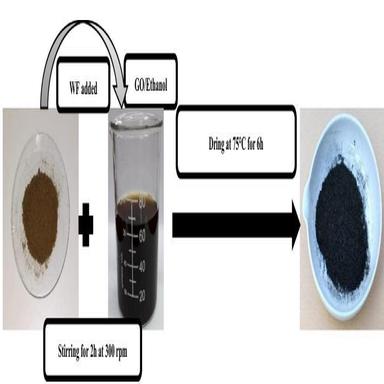
Schematic illustration of (WF/GO) hybrid preparation.